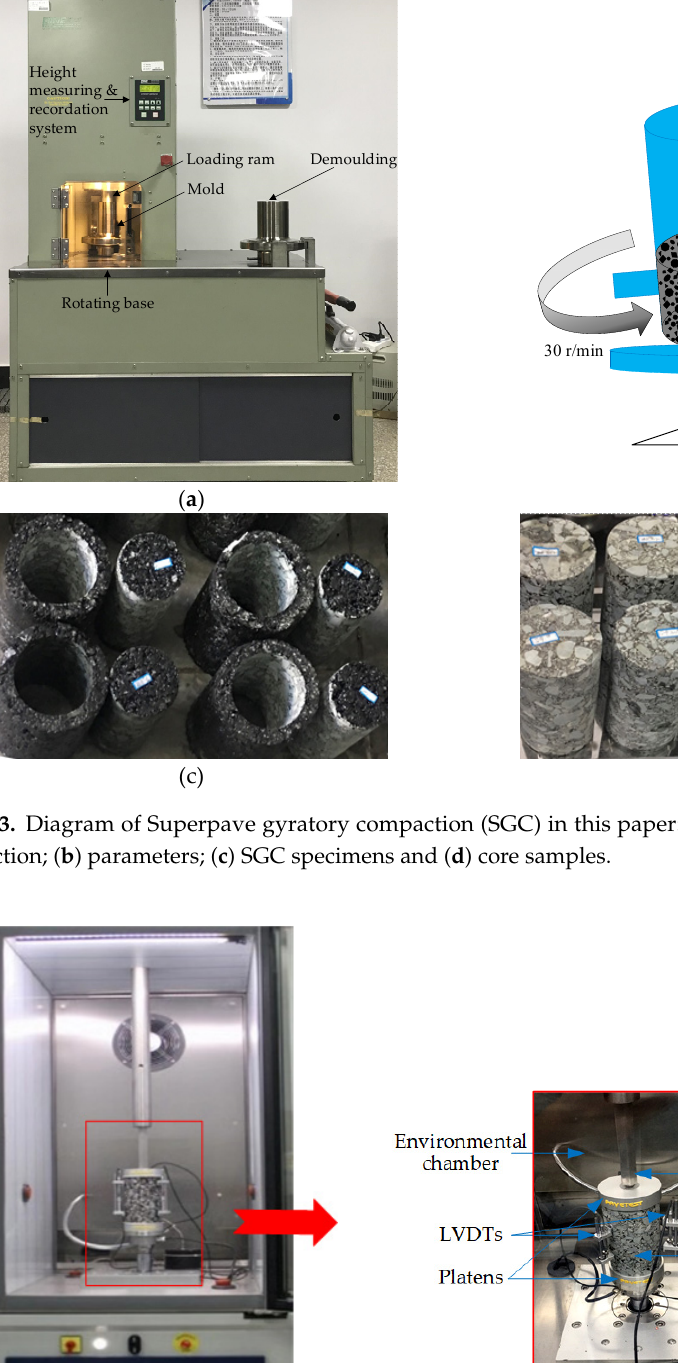
Figure 2. Gradation of stone mastic asphalt (SMA)-13.